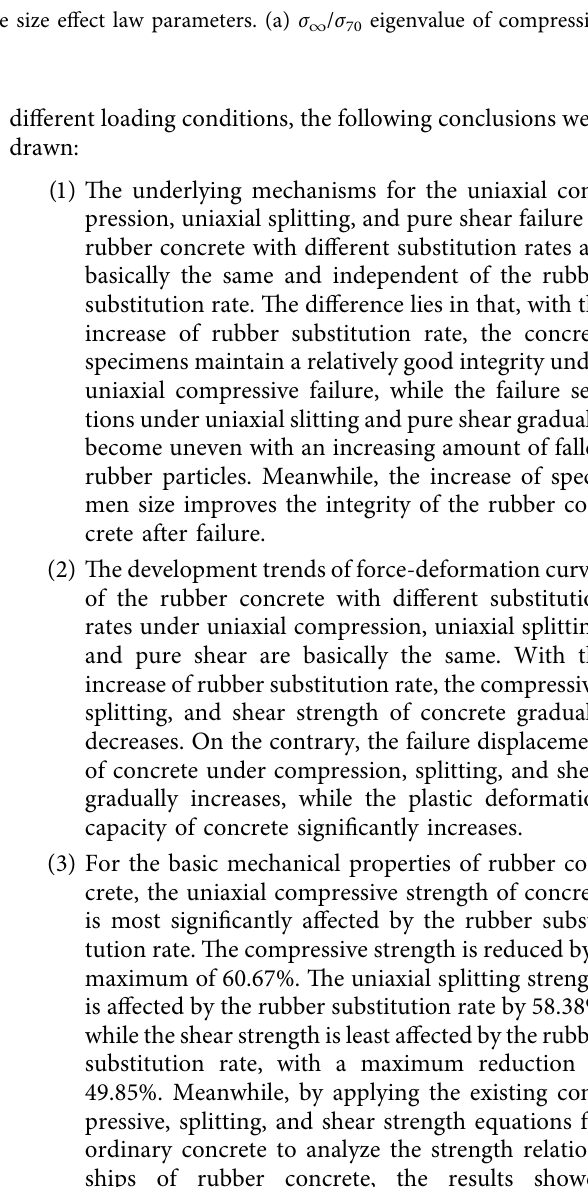
∞ / σ 70 eigenvalue of compressive